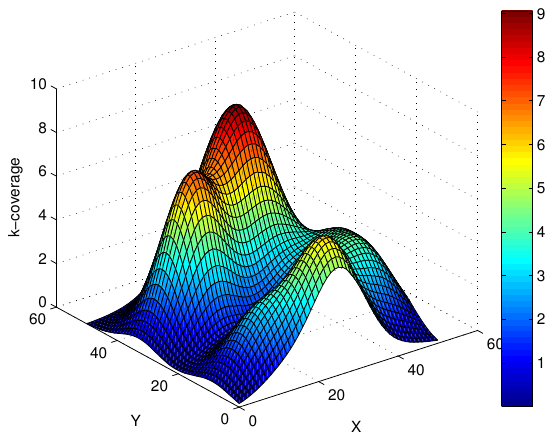
Figure 9. The k-coverage of the region by the sensors.